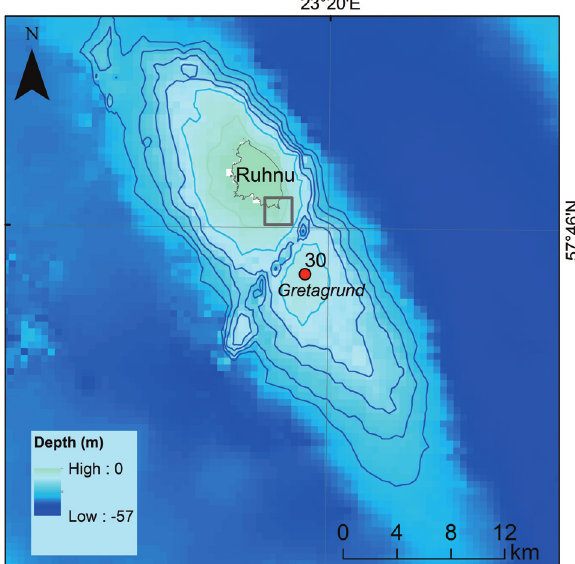
Fig. 3. The location scheme of the third-level (entire panel) and fourth-level (small box on Ruhnu) nested grids.